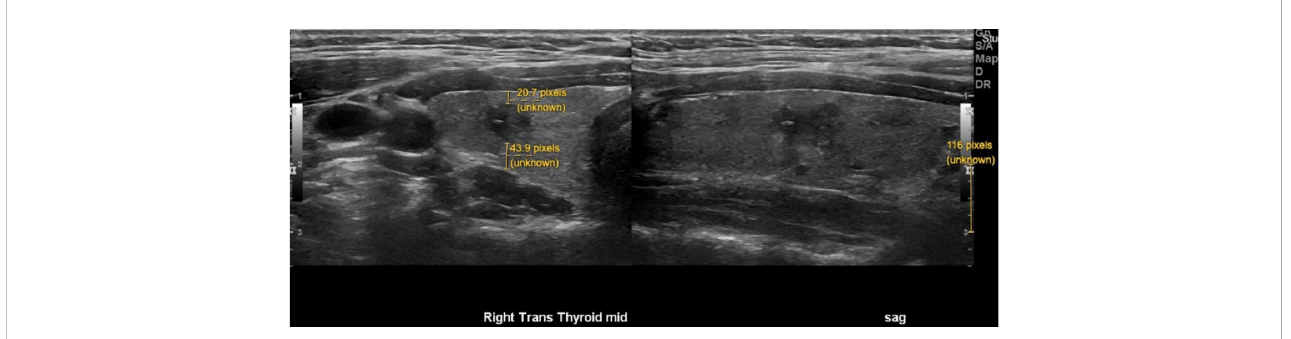
FIGURE 1 Representative image demonstrating preoperative ultrasound measurements of thyroid nodules. Size of nodule (white). Distance to anterior and posterior capsule (yellow). The pixel size was calibrated for each image using the scale provided by the ultrasound software (bottom right of